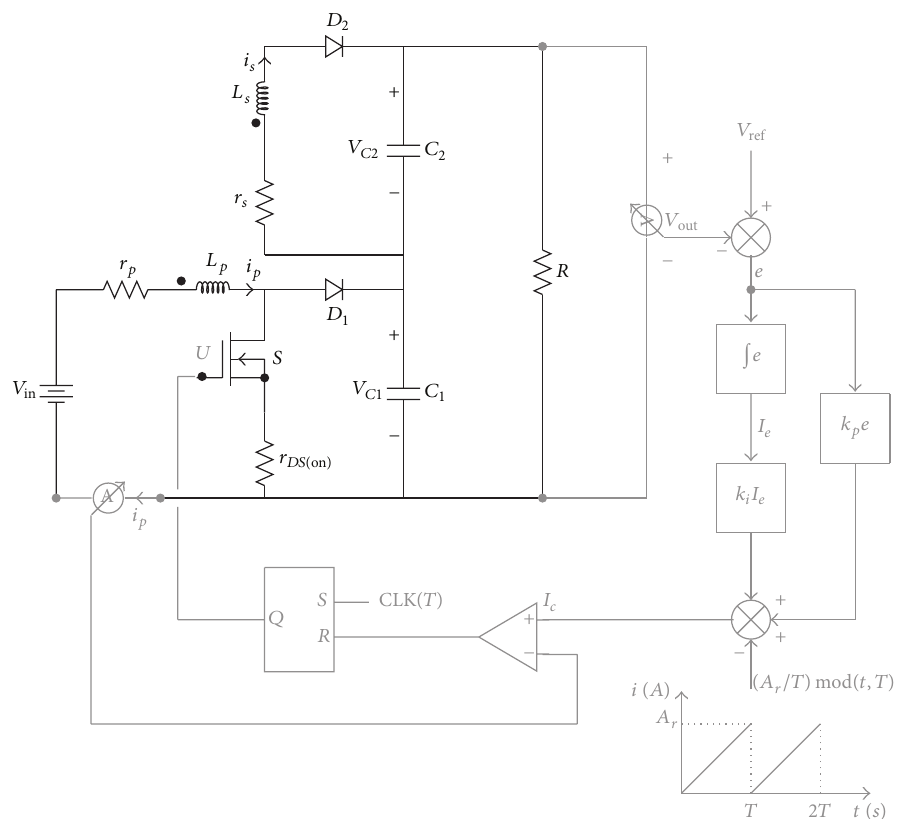
Figure 1: Schematic diagram of the peak-current control with compensation ramp for a boost-flyback converter.